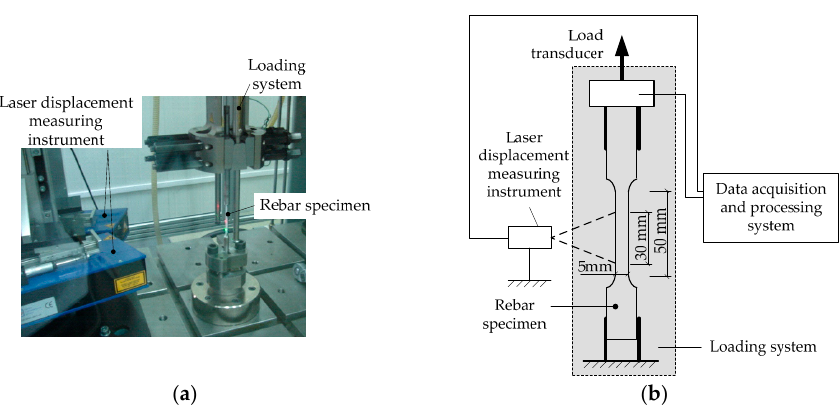
Figure 2. Test system for reinforcing steel bars under elevated strain rates: ( a ) Instron VHS160/100-20 and an installed specimen and ( b ) schematic diagram of testing.